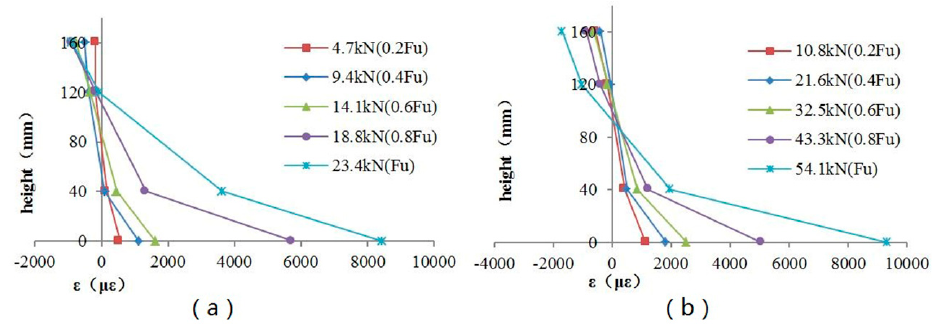
Figure 16. Strain profile for beams B5 and B6. ( a ) Beam B5 (reinforced with one-layer CFRP sheet); ( b ) beam B6 (reinforced with two layers of CFRP sheets).